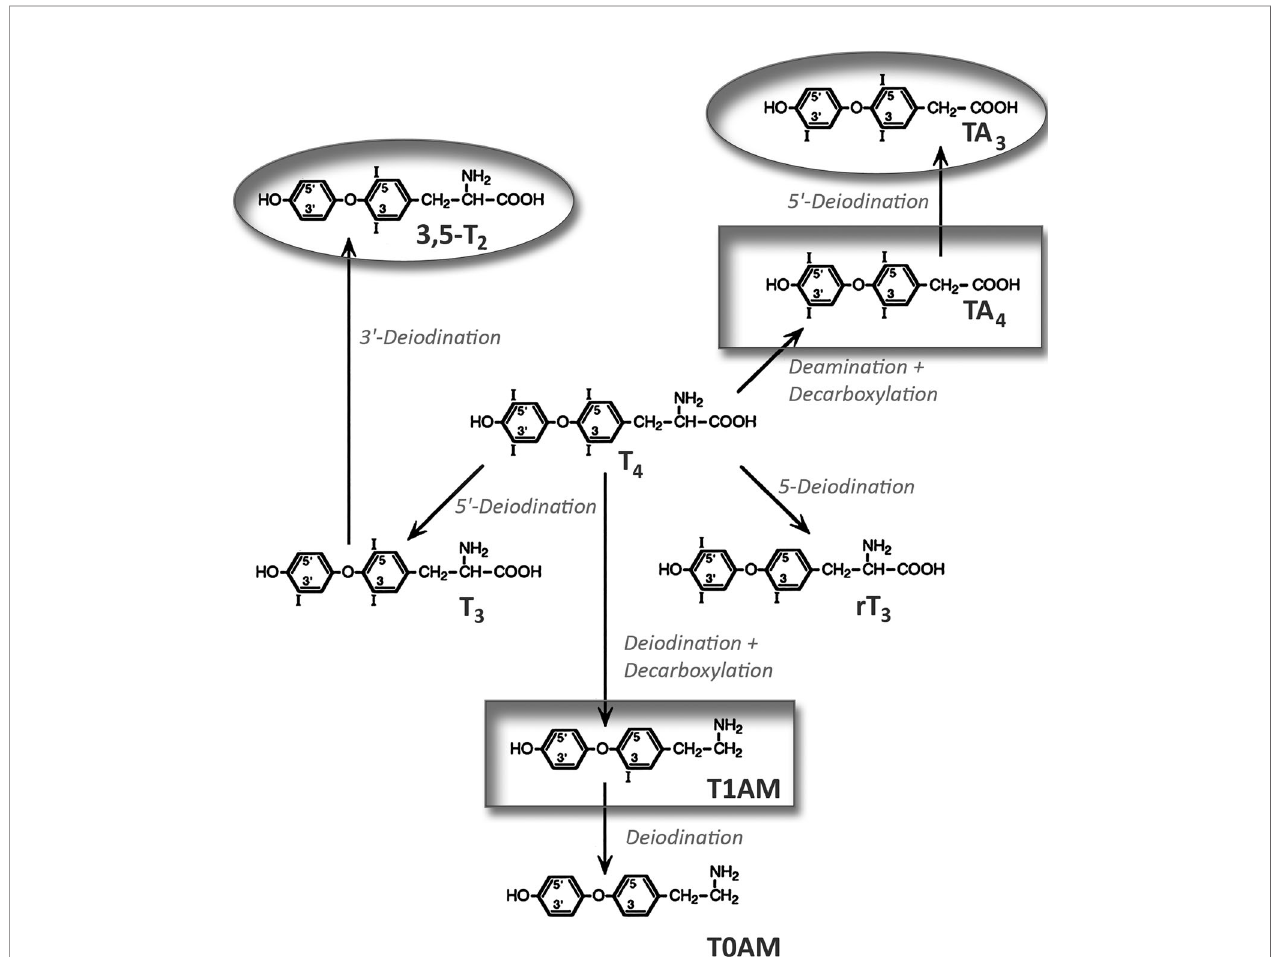
FIGURE 3 | Generation of biologically active thyroid hormone metabolites from thyroxine. Circles mark agonists and boxes antagonistically acting metabolites. 3,5- T2, 3,5-diiodothyronine; T1AM, 3-iodothyronamine; rT 3 , reverse triiodothyronine; TA 4 , tetraiodoacetic acid; T0AM, thyronamine; TA 3 , triiodoacetic